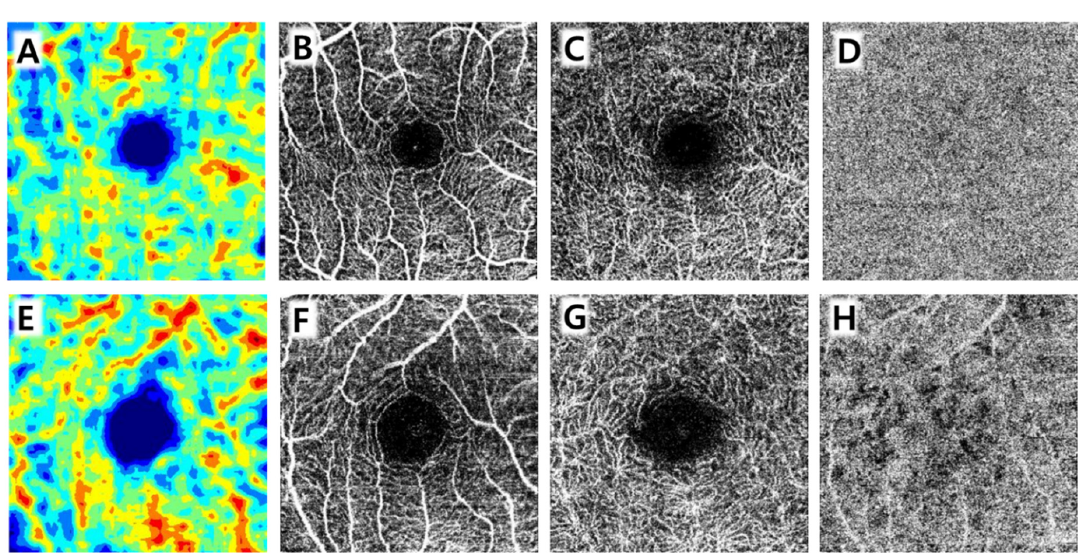
Figure 1. Representative OCTA images from participants of different ages. The top row shows OCTA images from a 14-year-old boy and the bottom row shows those from a 65-year-old man. The color-coded maps of the superficial capillary plexus of a 14-year old boy ( A ) and a 65-year-old man ( E ) show a difference in FAZ area, which is located in the center of the macula, and seen as a blue color. Furthermore, angiographic images of both subjects ( B, F ) demonstrated that a 65-year-old man had coarse superficial capillary density and this feature remained constant in the deep capillary plexus ( C, G ) and choriocapillaris ( D, H ).